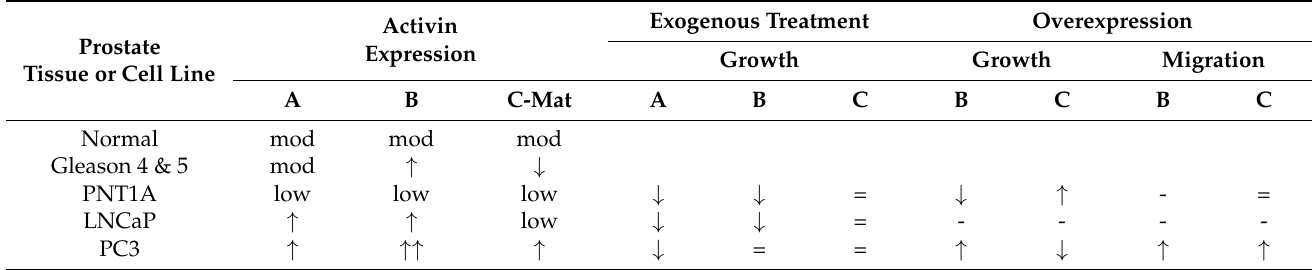
Table 3. Summary of INHBA, INHBB, INHBC expression and function in prostate